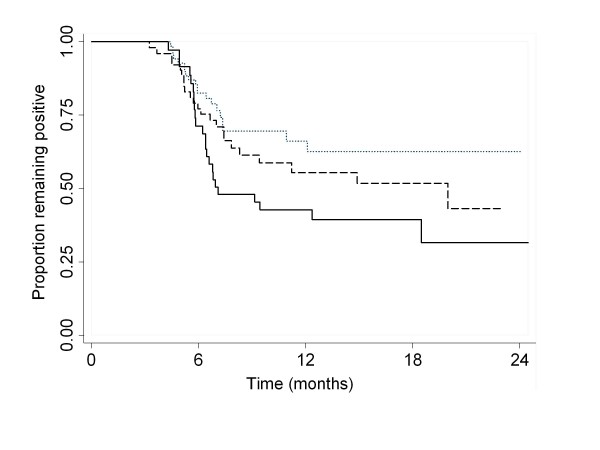
Cumulative positivity rate for infections with HPV types 16, 18, 31, and 45 according to tertiles of cumulative viral load for these 4 types. Unit of analysis is an individual infection episode, which makes observations not independent as a subject may contribute multiple episodes. Dotted line: upper tertile; dashed line: middle; solid line: lower tertile viral load.